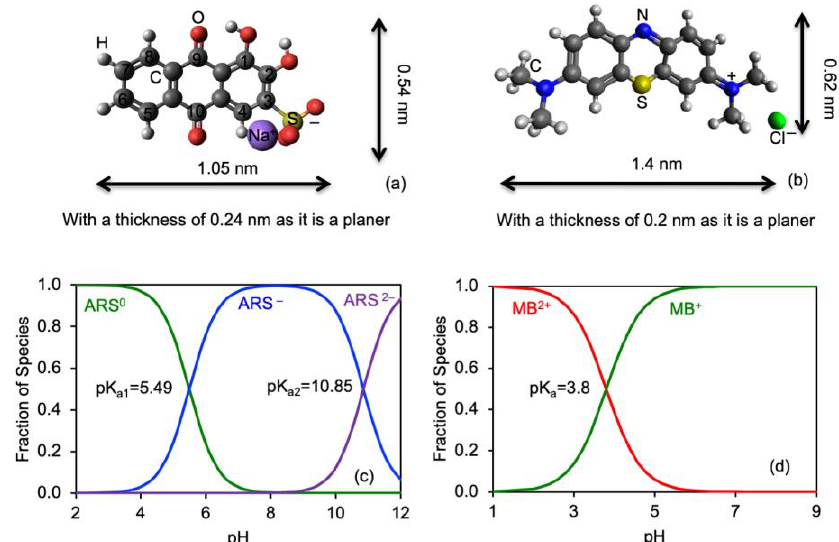
Figure 1. Molecular structures of ARS ( a ) and MB ( b ) and their pH-speciation diagrams ( c , d